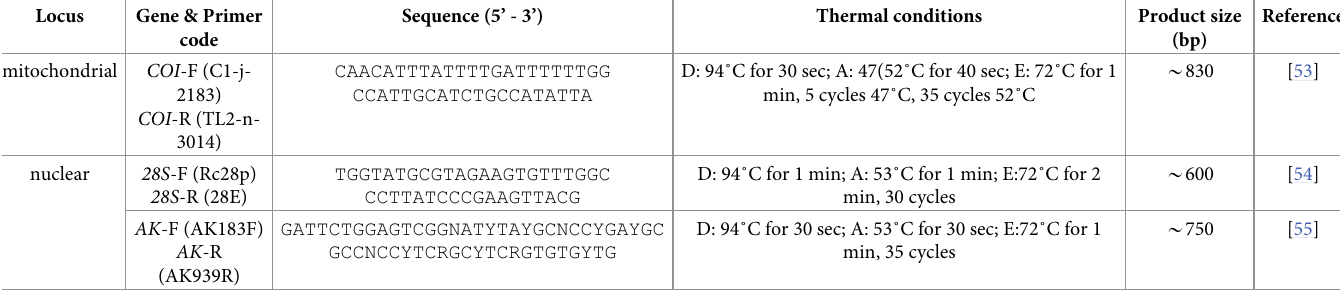
Table 1. Details of the primer sequences and thermal profile used for the amplification of target